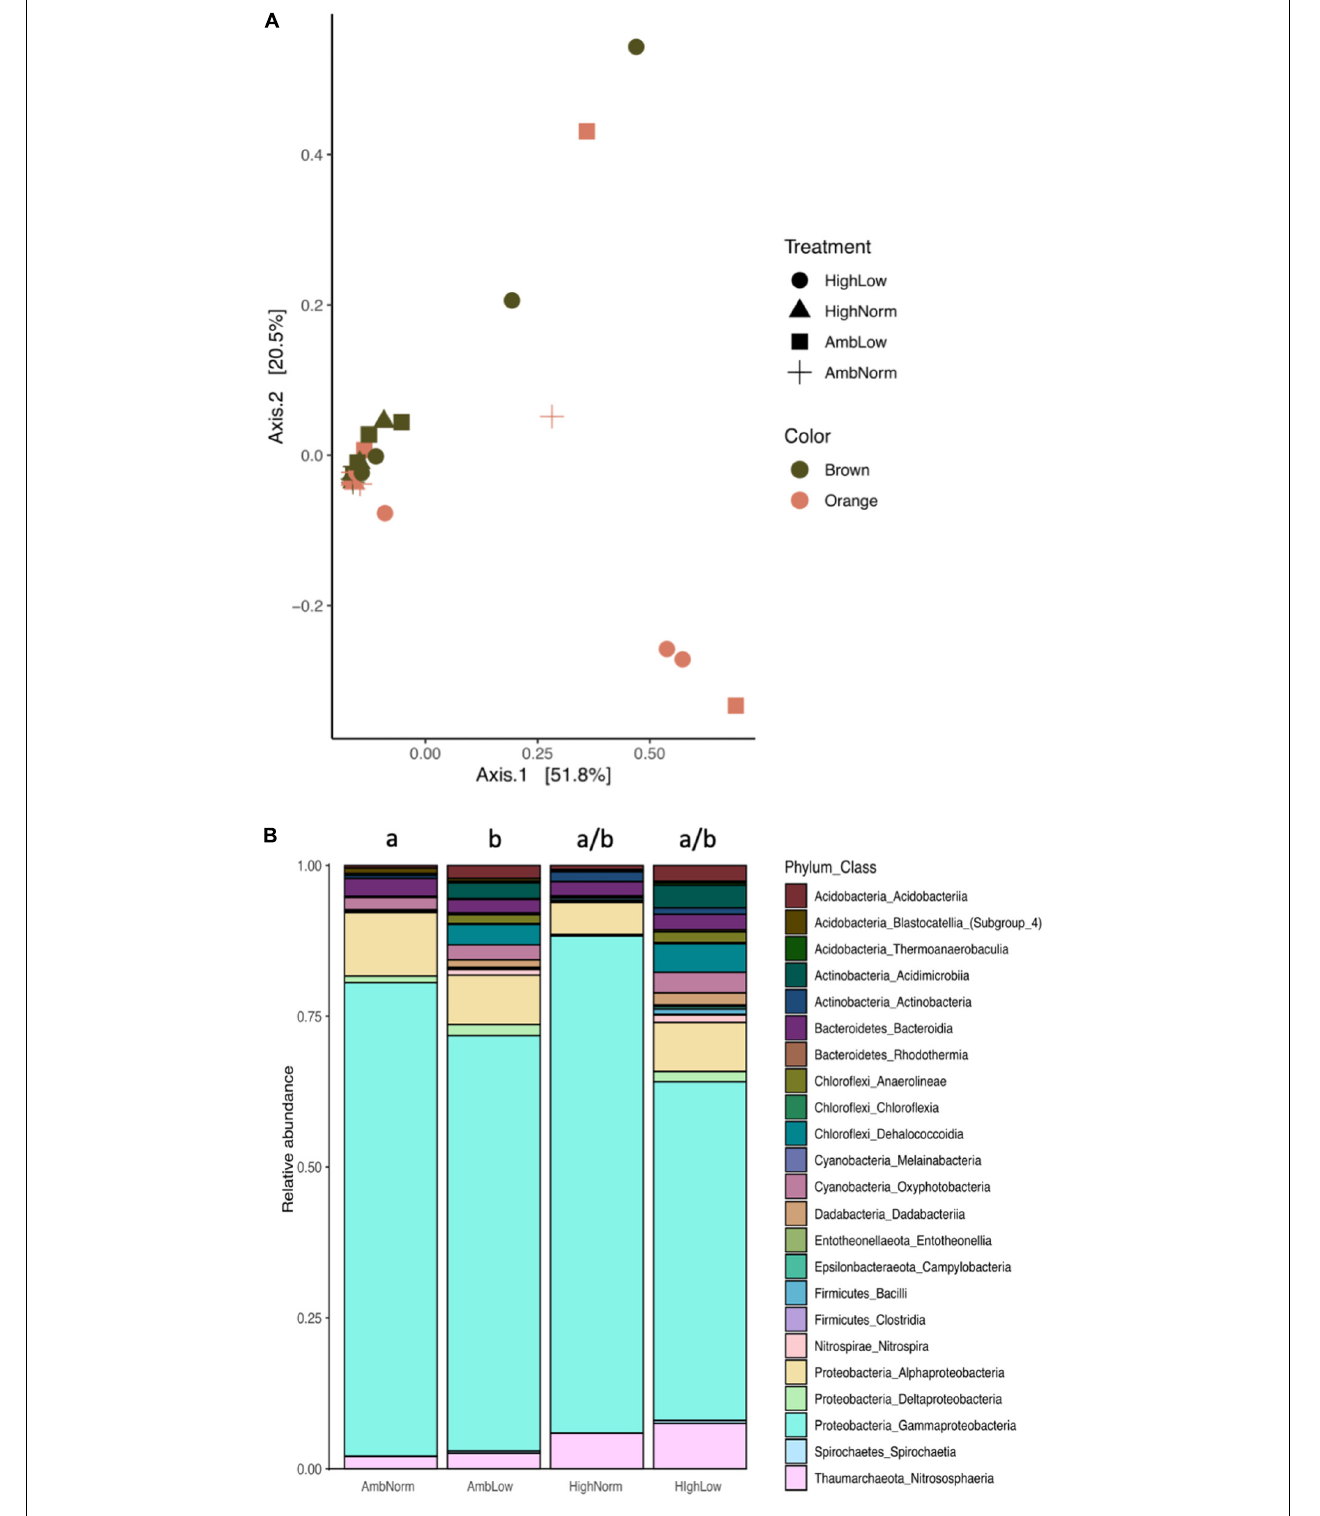
FIGURE 1 | Prokaryotic communities of Montastraea cavernosa . (A) Multidimensional analysis of the b–diversity estimates using Bray–Curtis distance matrices at the class level for each treatment group and color morph. (B) Average relative abundance of ASVs consolidated to class level for each treatment group and color morph. Common superscripts indicate treatment groups not significantly different from each other (Tukey’s HSD, P > 0.05).